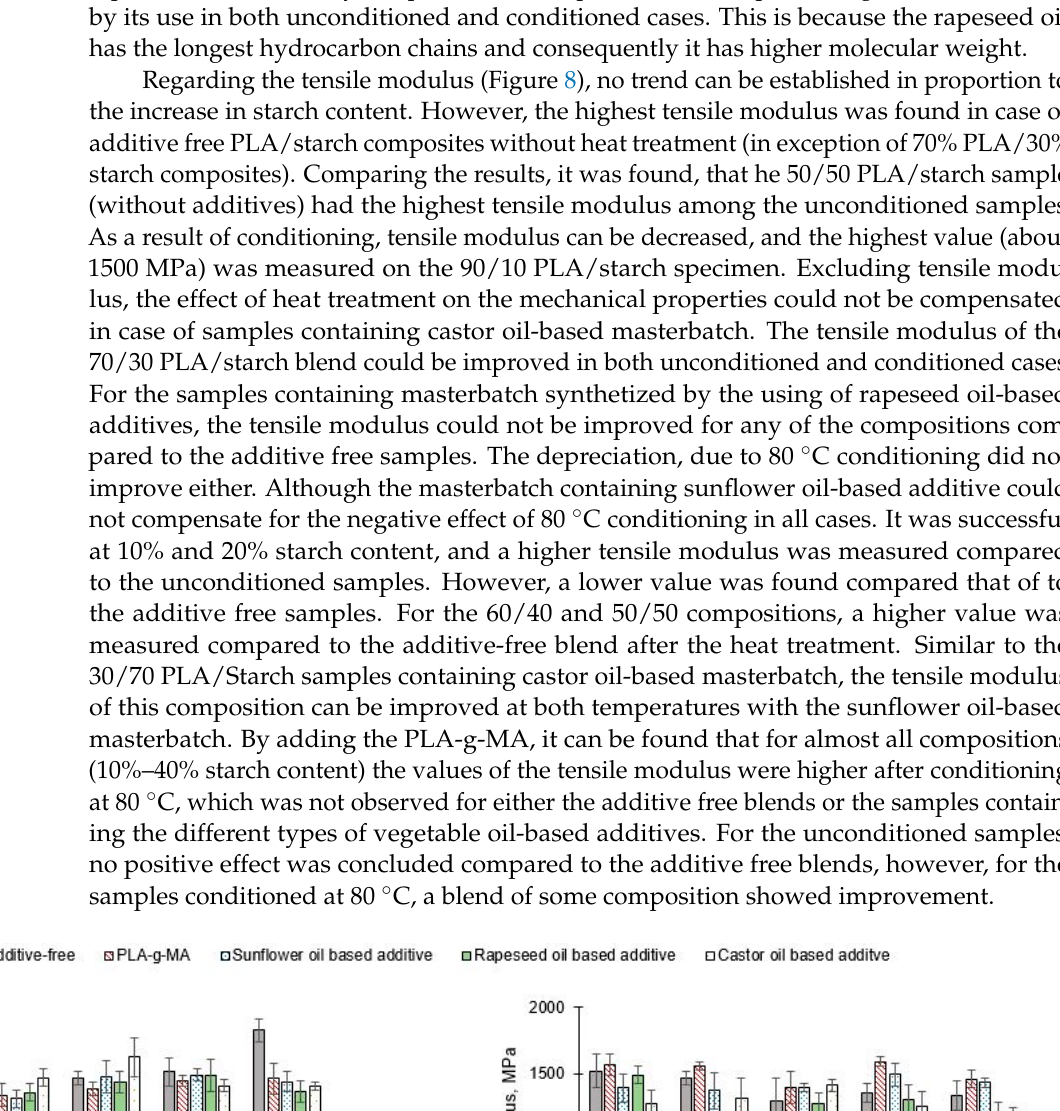
Figure 9. Flexural modulus of unconditioned and conditioned PLA/starch blends. The effect of conditioning was eliminated with only PLA-g-MA at all ratios. In addi- tion, unconditioned samples showed a significant improvement over the flexural modu- lus of the additive-free PLA/starch blends (for instance 260 MPa improvement was meas- ured in case of 90/10 PLA/starch composition). Sunflower oil-based additives also caused a significant improvement in all blends of the examined composition and the disad- vantage of the heat treatment can been reduced. Overall, for both conditioned and uncon- ditioned samples, the flexural modulus could be improved with each masterbatch in case of 10% starch content. Based on data in Figure 10, it was observed that increasing starch content causing a decrease in the elongation at break considering both the unconditioned and conditioned specimens. This tendency was more or less observed in the sample series containing the masterbatch. The effect of conditioning did not cause a large change in elongation at break. The largest change was a decrease from 5.6% elongation at break to 4.6% in case of additive free 30/70 PLA/starch blend. A decrease in the elongation at break was observed at both temperatures using PLA-g-MA. By using a rapeseed oil-based additive, the elon- gation at break could be increased regardless of composition and conditioning. Irrespec- tive of conditioning, the castor oil and sunflower oil-based additives also resulted an in- crease in case of blends containing 10% and 20% starch as well.